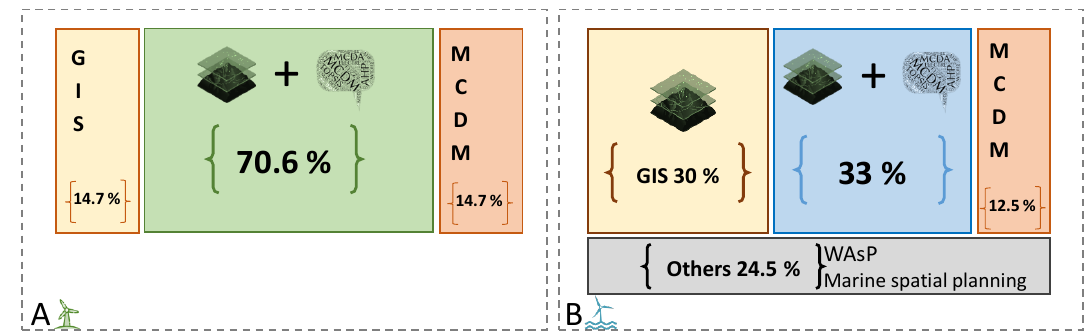
Figure 8. Statistics and comparison of location methodologies (2008–2018). ( A ) Onshore wind power plant. ( B ) Offshore wind power